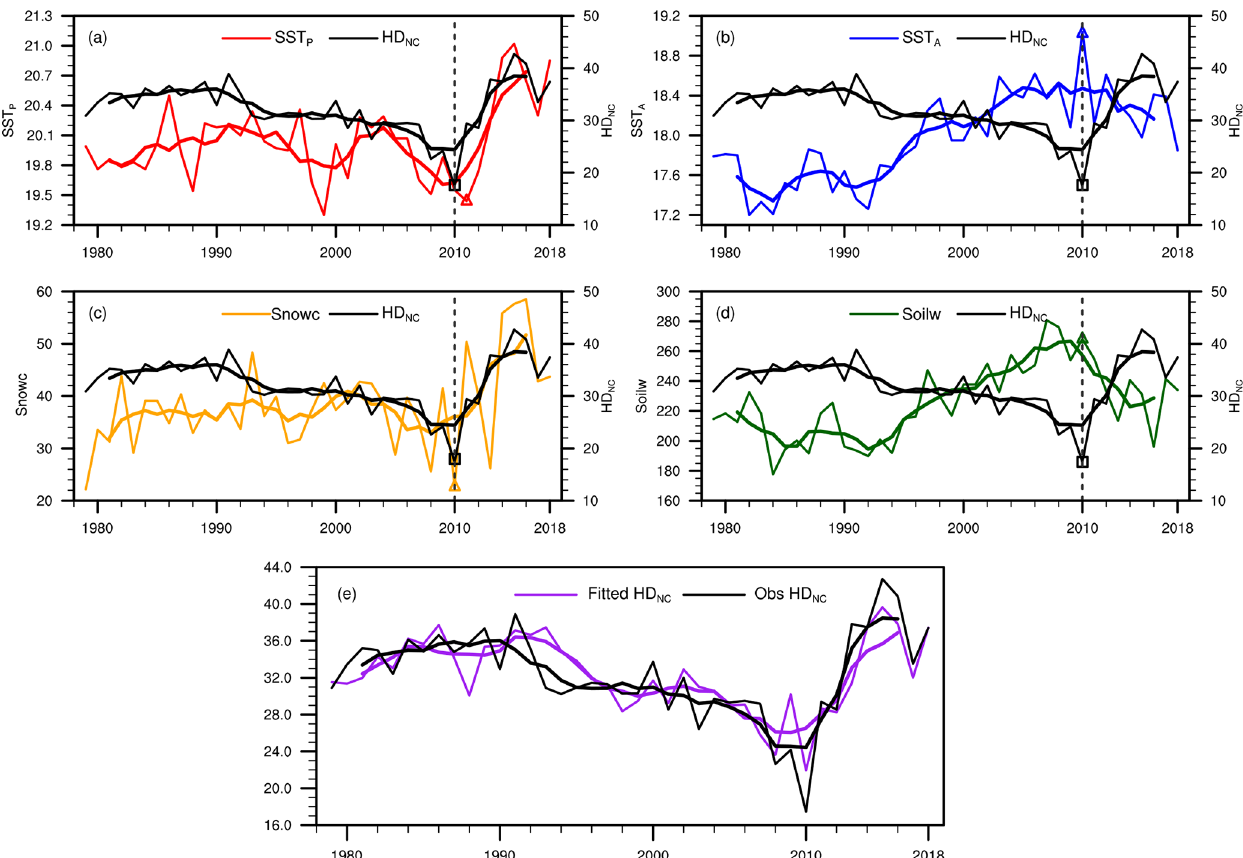
Figure 4. Variations in HD NC (in black) and the SST P (unit: ◦ C; a , red), SST A (unit: ◦ C; b , blue), Snowc (unit: %; c , yellow) and Soilw (unit:mm; d , green) indices as well as the HD NC values fitted by the MLR model for the above four factors (unit: days; e , purple) from 1979 to 2018. Thick lines indicate 5-year running averaged time series. The rectangles and triangles indicate the inflection points of HD NC and the four indices, which were tested by the Mann–Kendall test.